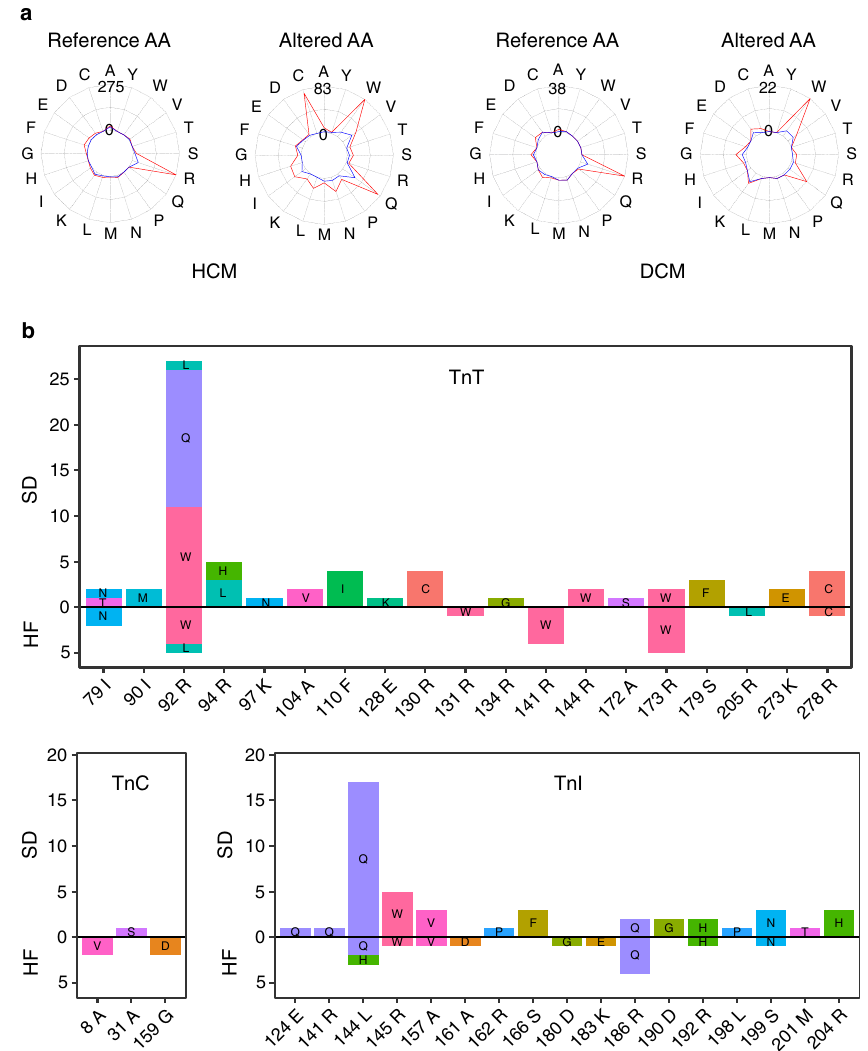
Fig. 3 Distribution of amino acid variants for cause of death and phenotypes. a Frequencies of reference and altered amino acids in troponins among cases of HCM and DCM. The red line indicates total number of cases with either HCM or DCM and the blue line indicates cases carrying variants at known protein structure sites. Amino acid substitutions in troponins among index cases with mortality from heart failure (HF) or sudden cardiac death (SD). b Positions of protein sequence and reference amino acid are shown on x -axis and the mortality number on y